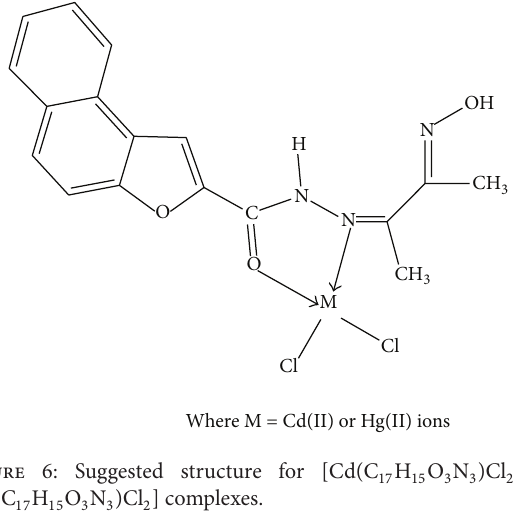
Figure 6: Suggested structure for [Cd(C 17 H 15 O 3 N 3 )Cl 2 ] or [Hg(C 17 H 15 O 3 N 3 )Cl 2 ]